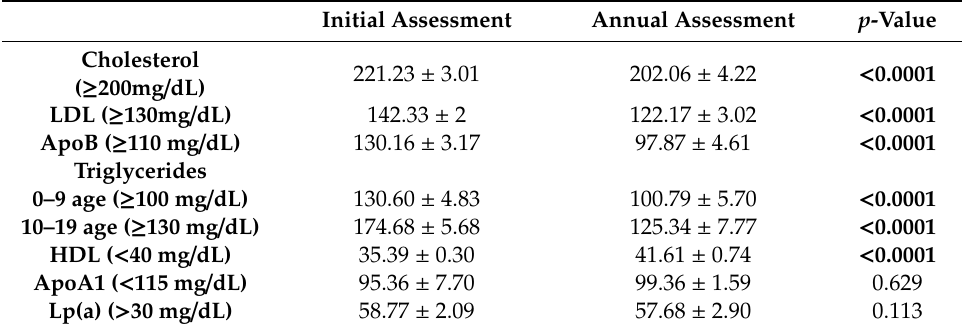
8. Lipid profile alterations indicative of dyslipidemia following the multidisciplinary